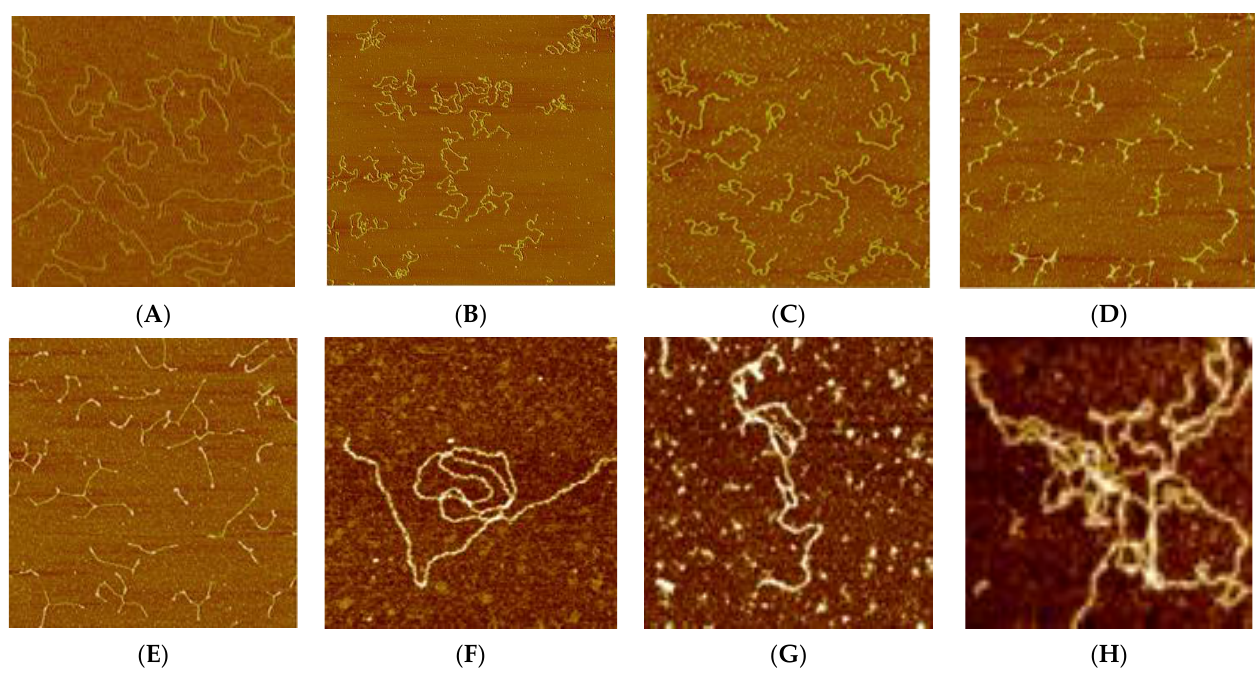
Figure 10. AFM images of DNA ( A ) and DNA complexes with cis-DDP ( B , C ), trans-DDP ( D , E ), Pt1 ( F ), Pt2 ( G ), and Pt3 ( H ). Size of images is 2 µ m ( A ), 3 µ m ( B – E ) and 1 µ m ( F – H ), ( B , D ) Fixation on mica was carried out at C(DNA) = 0.001 %, C(cis-DDP) = 4 × 10 − 5 M ( B ) and 5.5 × 10 − 5 M ( C ) C(trans-DDP) = 3.9 × 10 − 5 M ( D ) and 5.3 × 10 − 5 M ( E ). C(Pt1) = C(Pt2) = C(Pt3) = 5 × 10 − 5 M. C(MgCl 2 ) = 5 × 10 − 4